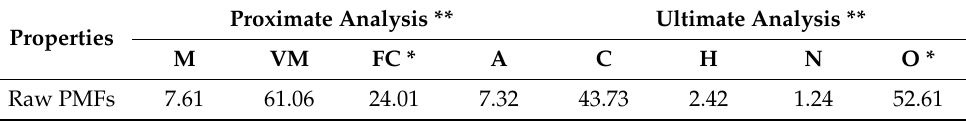
Table 1. Proximate and ultimate analysis of oil palm male flowers